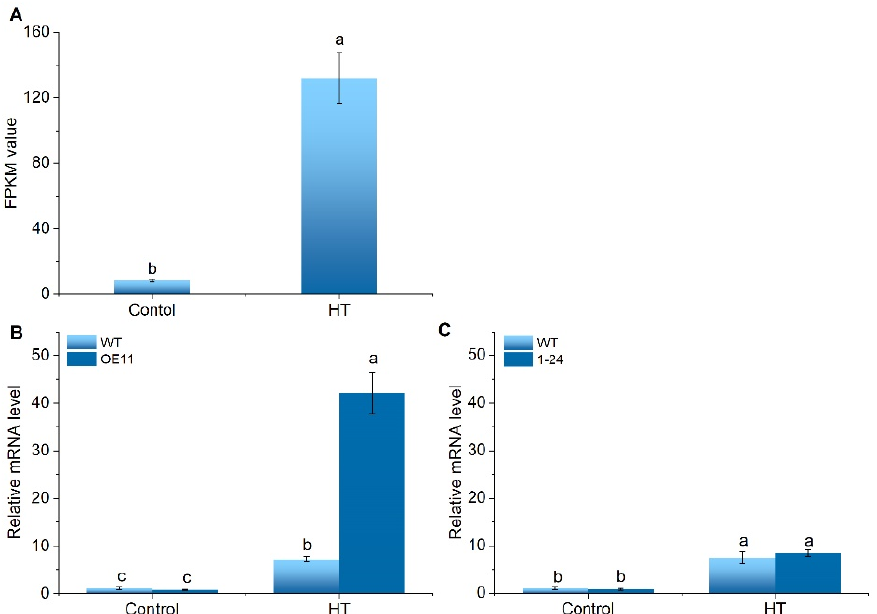
Figure 1. High temperature-induced SlCML39 expression is regulated by SlMPK1 under high temperature (HT). ( A ) The transcript level of SlCML39 was induced by HT using RNA-seq analysis of HT-responsive genes in tomato leaves [24]. ( B ) qRT-PCR analysis of SlCML39 expression in wild-type (WT) and SlMPK1 -overexpressing line OE11 under HT. ( C ) qRT-PCR analysis of SlCML39 expression in WT and SlMPK1 -RNA interference line 1–24 under HT. The UBI gene was used as an internal standard. Total RNAs were extracted from WT, OE11, or 1–24 leaves under control (25 °C) and HT (42 °C) for 4 h. The bar represents the mean ± SD values of three replicates ( n = 3). According to the LSD test, the statistical differences between samples are marked with different letters ( p < 0.05).